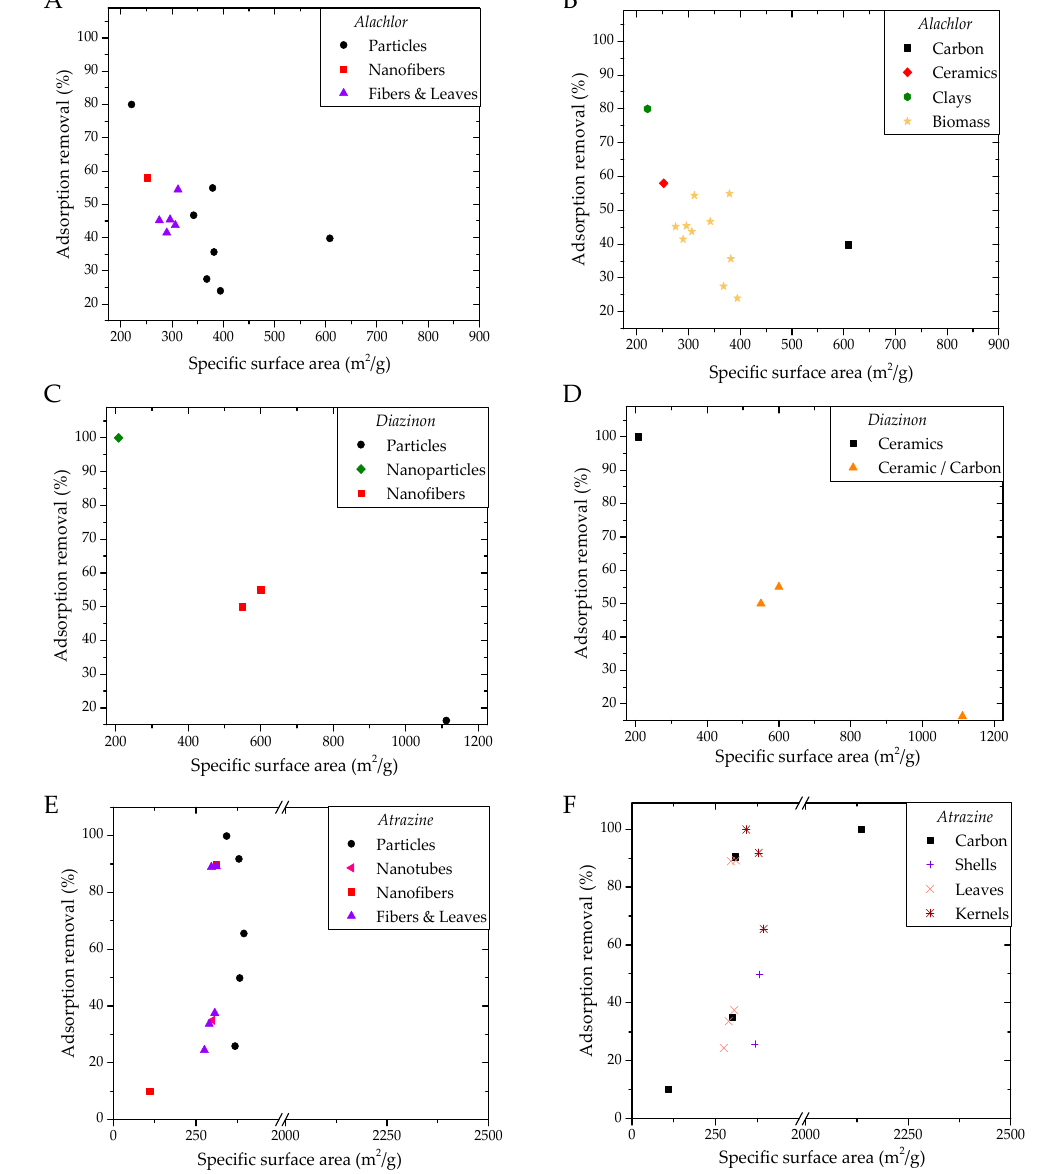
Figure 1. Adsorption removal (%) related to adsorbent specific surface area for different adsorptive structures and for different adsorbent compositions against Alachlor ( A , B ), Atrazine ( C , D ) and Diazinon ( E , F ).